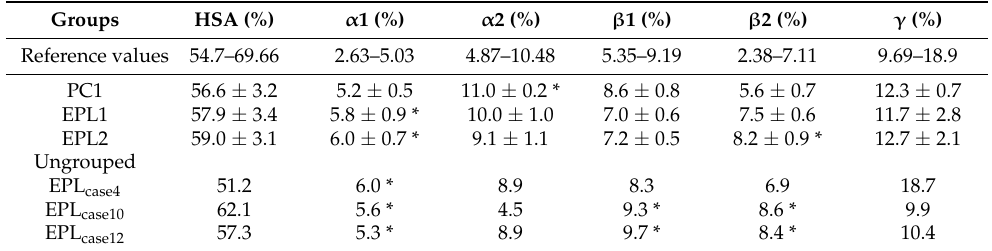
Table 4. Concentration of the main plasma proteins fractions (mean ± SD) determined by capillary electrophoresis and presented as a percentage of the total protein content for the groups under study.